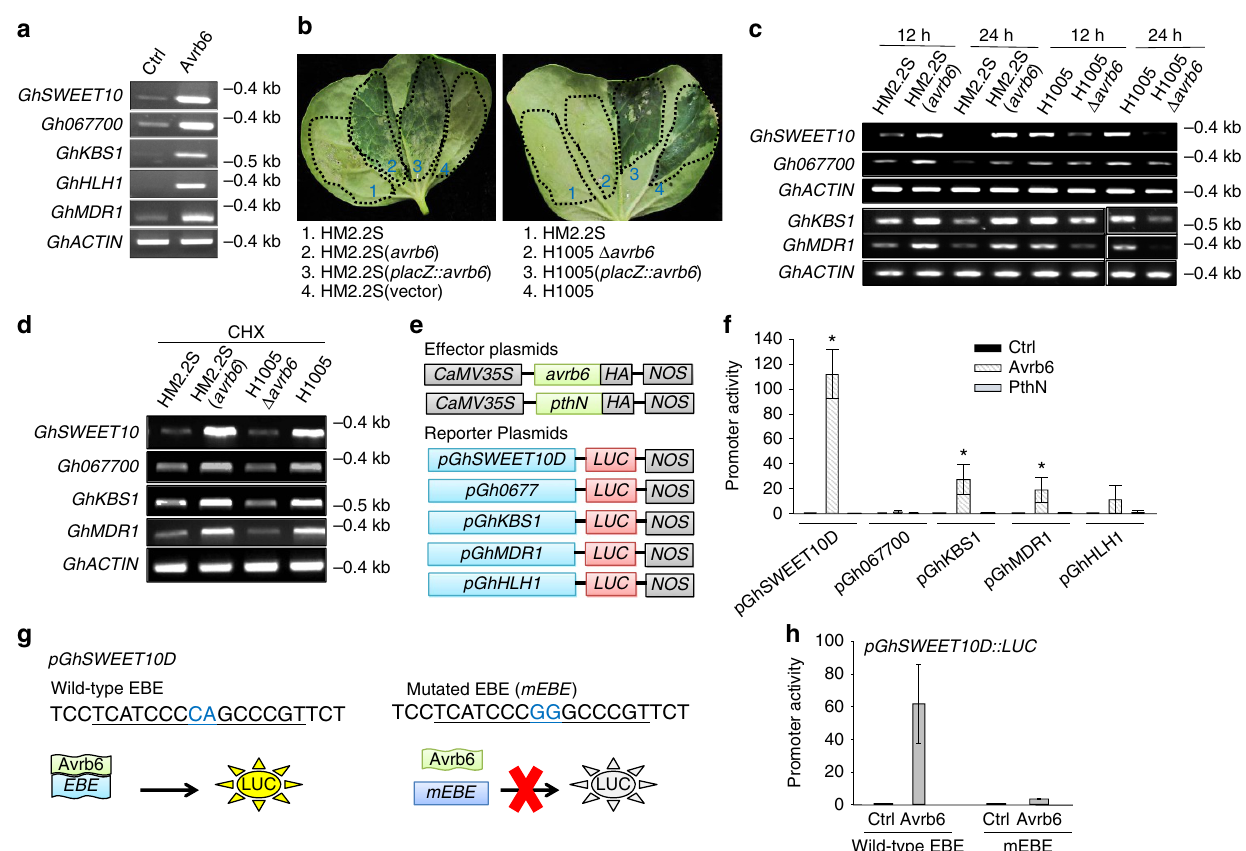
Figure 3 | Avrb6 directly induces cotton gene transcription in the absence of protein synthesis. ( a ) RT–PCR analysis of Avrb6 upregulated genes in cotton protoplasts. Cotton protoplasts of Ac44E were transfected with avrb6-HA or a vector control (Ctrl) and incubated for 12h before RNA isolation. GhACTIN was used as an internal control. ( b ) Avrb6 contributes to water-soaking development in cotton. Cotyledons from 2-week-old Ac44E cotton were syringe-inoculated with different Xcm strains at OD 600 ¼ 0.1 and photographed 4 days after infiltration. Inoculation areas are indicated by dotted lines. ( c ) RT–PCR analysis of Avrb6 upregulated genes in cotton upon Xcm infection. Cotyledons from 2-week-old Ac44E cotton were syringe-inoculated with different Xcm strains. Tissues were collected at 12 and 24 hpi. ( d ) RT–PCR analysis of Avrb6 upregulated genes in the presence of CHX. Cotyledons from 2-week-old cotton were syringe-inoculated with different Xcm strains in 50 m M CHX. Tissues were collected at 24 hpi for RT–PCR. ( e ) Schematic diagram of the effector and reporter constructs. The reporter construct contains an expression cassette with a LUC reporter gene under the control of a candidate gene promoter. The effector construct contains either Avrb6 or PthN with an HA-epitope tag under the control of the CaMV 35S promoter. ( f ) Transcriptional activity of Avrb6 in cotton protoplasts. Protoplasts were co-transfected with a reporter construct and avrb6 , pthN or a vector control (Ctrl), and were collected 12h after transfection. UBQ10-GUS was included in the transfections as an internal control. The luciferase activity was normalized with GUS activity. The data are shown as mean ± s.d. ( n ¼ 3) from three independent repeats. Asterisks indicate significant difference using two-tailed t -test ( P o 0.05). ( g ) Schematic diagram of the transactivation assay of wild-type and mutated EBE (mEBE) in pGhSWEET10D in response to Avrb6. The nucleotide sequence containing the putative EBE is shown and the two nucleotides that were mutated are highlighted in blue. ( h ) Transcriptional activity of GhSWEET10D with wild type and mEBE in response to Avrb6. Cotton protoplasts were co-transfected with pGhSWEET10D::LUC carrying wild type or mEBE and Avrb6 or a vector control (Ctrl). The data are shown as mean ± s.d. ( n ¼ 3) from three independent repeats. The above experiments were repeated three times with similar